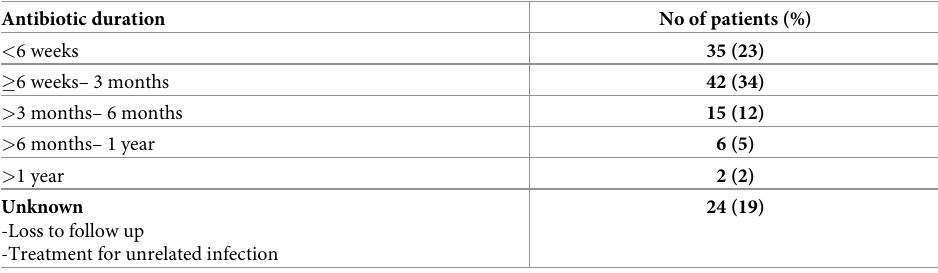
Table 4. Duration of antibiotic therapy.